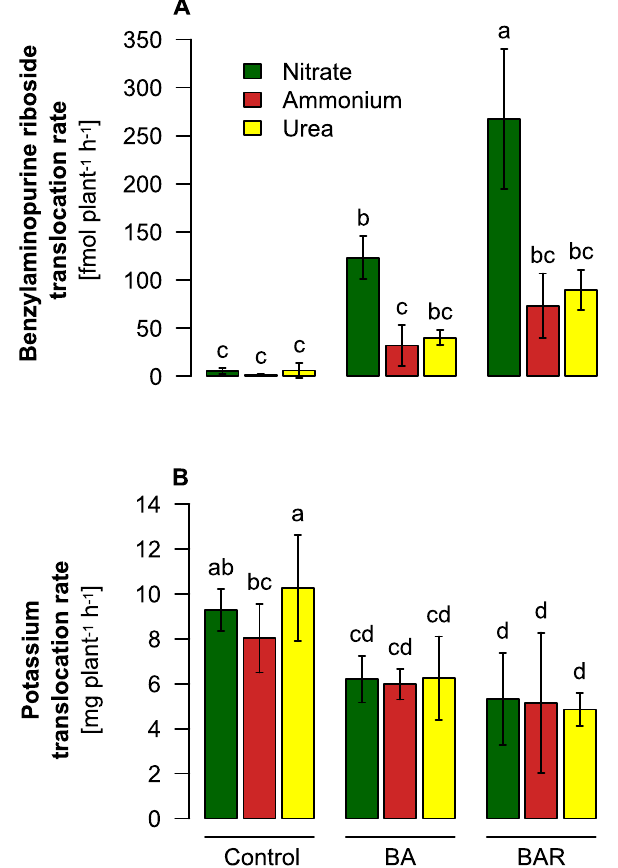
Figure 3. Translocation rate of benzylaminopurine riboside (BAR) and potassium in the xylem sap of barley plants as affected by the presence of different nitrogen forms. ( A ) Benzyl-aminopurine translocation rate and ( B ) potassium translocation rate as determined in the xylem bleeding sap from spring barley precultured hydroponically until the 5-leaf stage on ammonium nitrate, then for 24 h on N-free nutrient solution and then for 48 h on pH-buffered 0.5 mM potassium nitrate, urea or ammonium sulfate. BAR was supplied at a concentration of 10 µM 12 h before collection of the xylem bleeding sap. Bars represent means ± SD, n = 3 biological replicates. Different letters indicate significant differences among treatments at p < 0.05 by Tukey’s